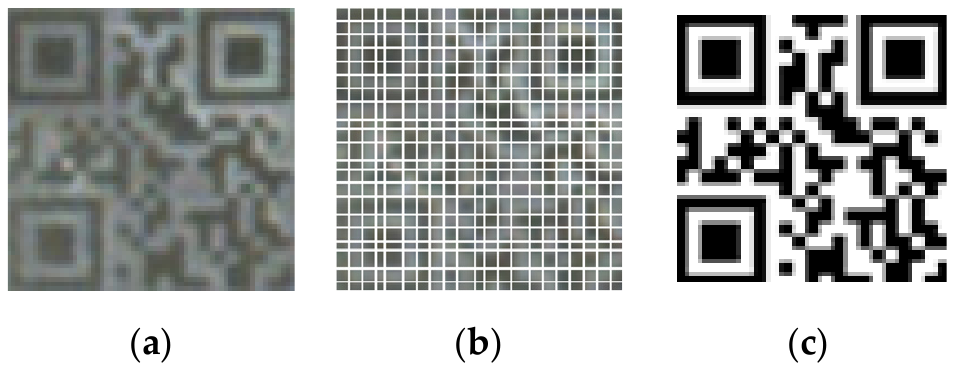
Figure 15. Images depicting the QR code structure extraction process: ( a ) QR code, ( b ) result of grid segmentation, and ( c ) extracted structure of the QR code.